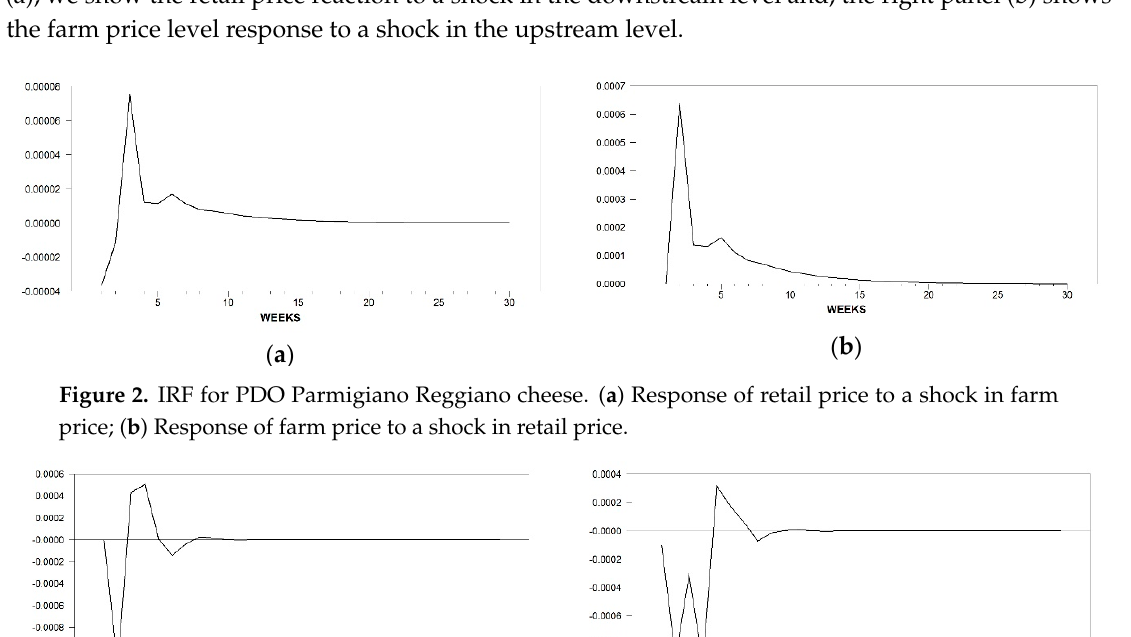
Figure 2. IRF for PDO Parmigiano Reggiano cheese. ( a ) Response of retail price to a shock in farm price; ( b ) Response of farm price to a shock in retail price.